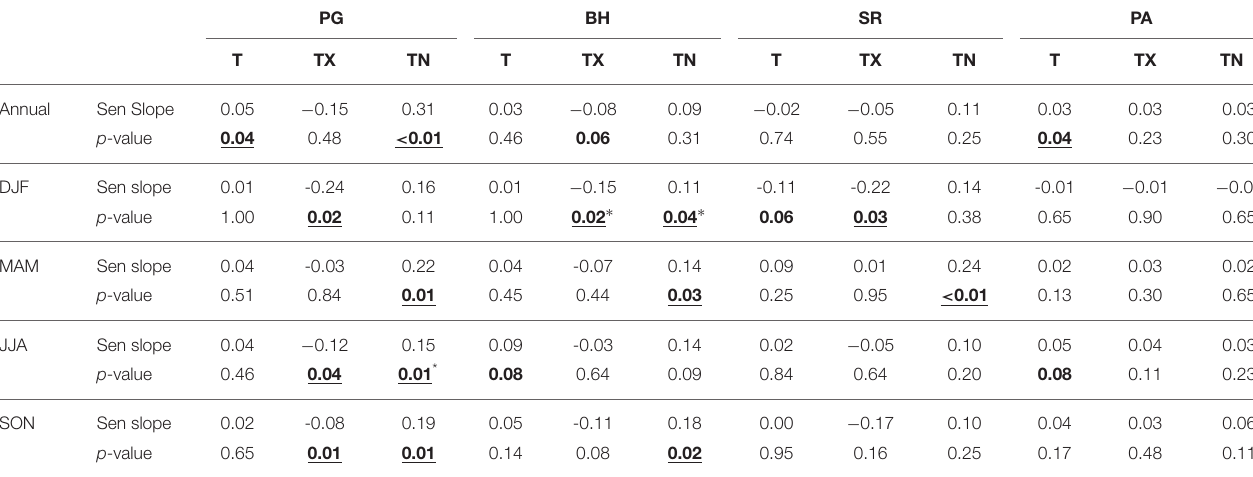
TABLE 5 | Statistical results of the trend analysis for annual and seasonal mean (T), maximum (TX), and minimum (TN) air temperature in ◦ Ca − 1 for AWS Paso Galería (PG), AWS Puerto Bahamondes (BH), AWS Skyring (SR), and WS Punta Arenas (PA). PG